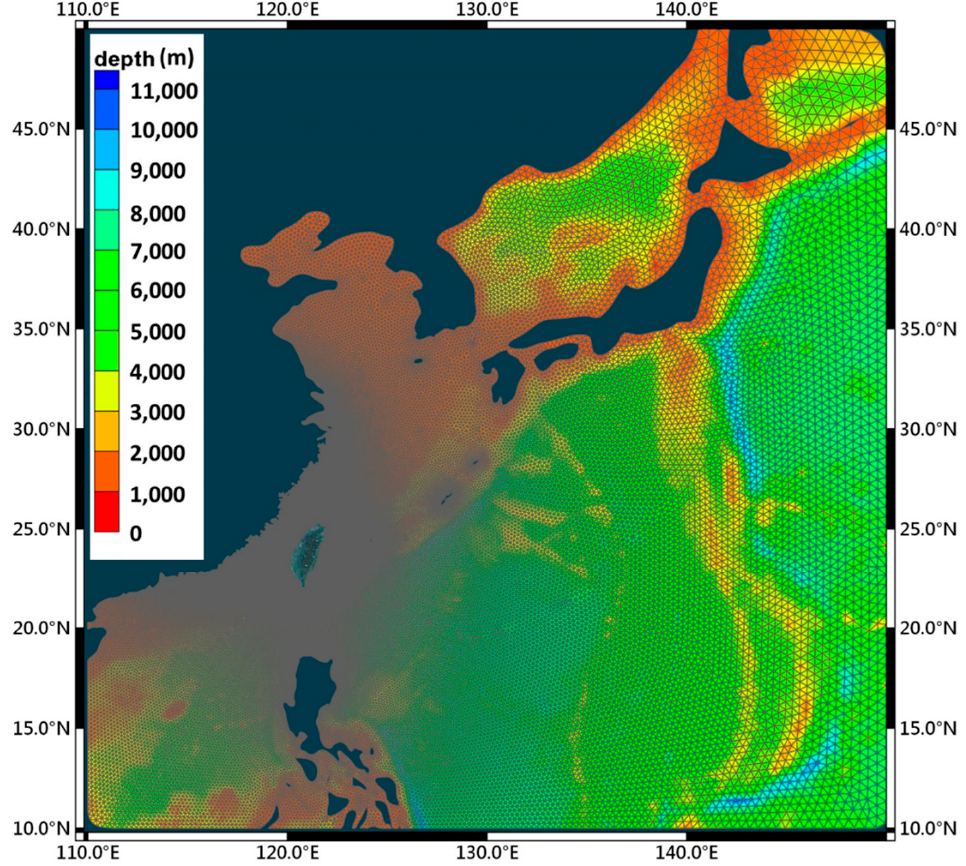
Figure 3. Bathymetry and unstructured grid for Far-field simulation.